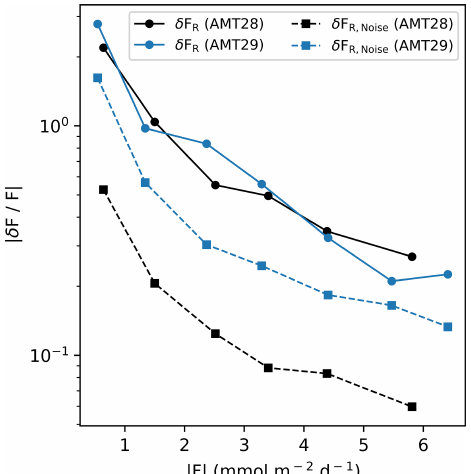
Figure D1. Comparison of the relative total random uncertainty and the relative random error component due to white noise for different gas analysers. A Picarro G2311-f gas analyser was used on AMT28 and a LI-7200 infrared gas analyser on